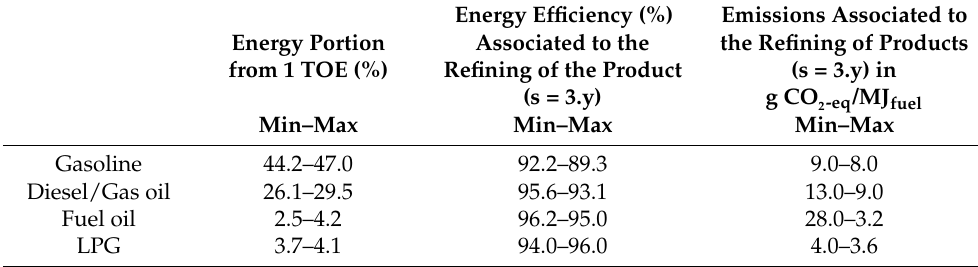
Table 2. Inventory of the refining processes by